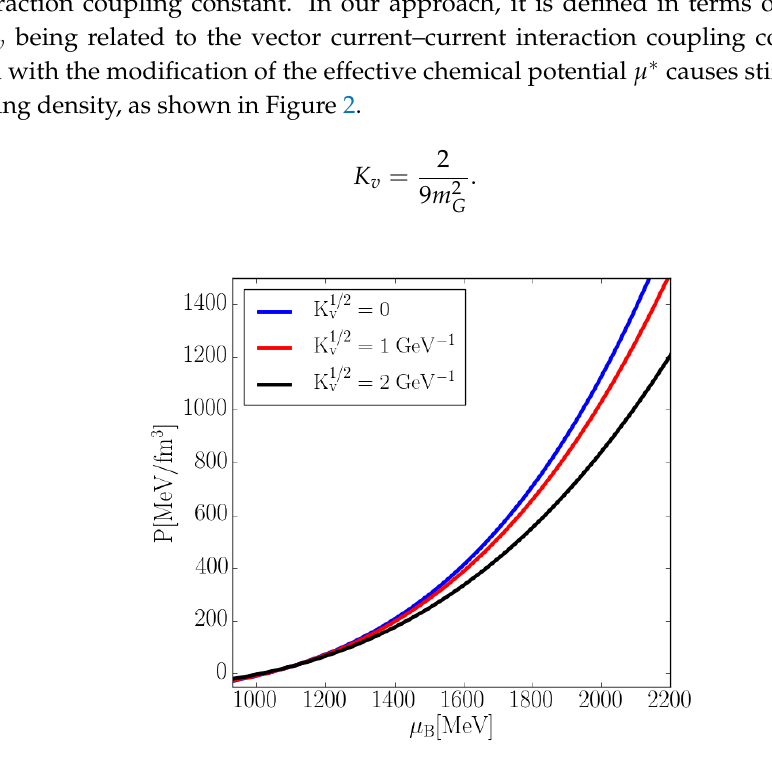
Figure 2. Impact of vector interactions on the stiffness of the EoS. B 1/4 χ = 150